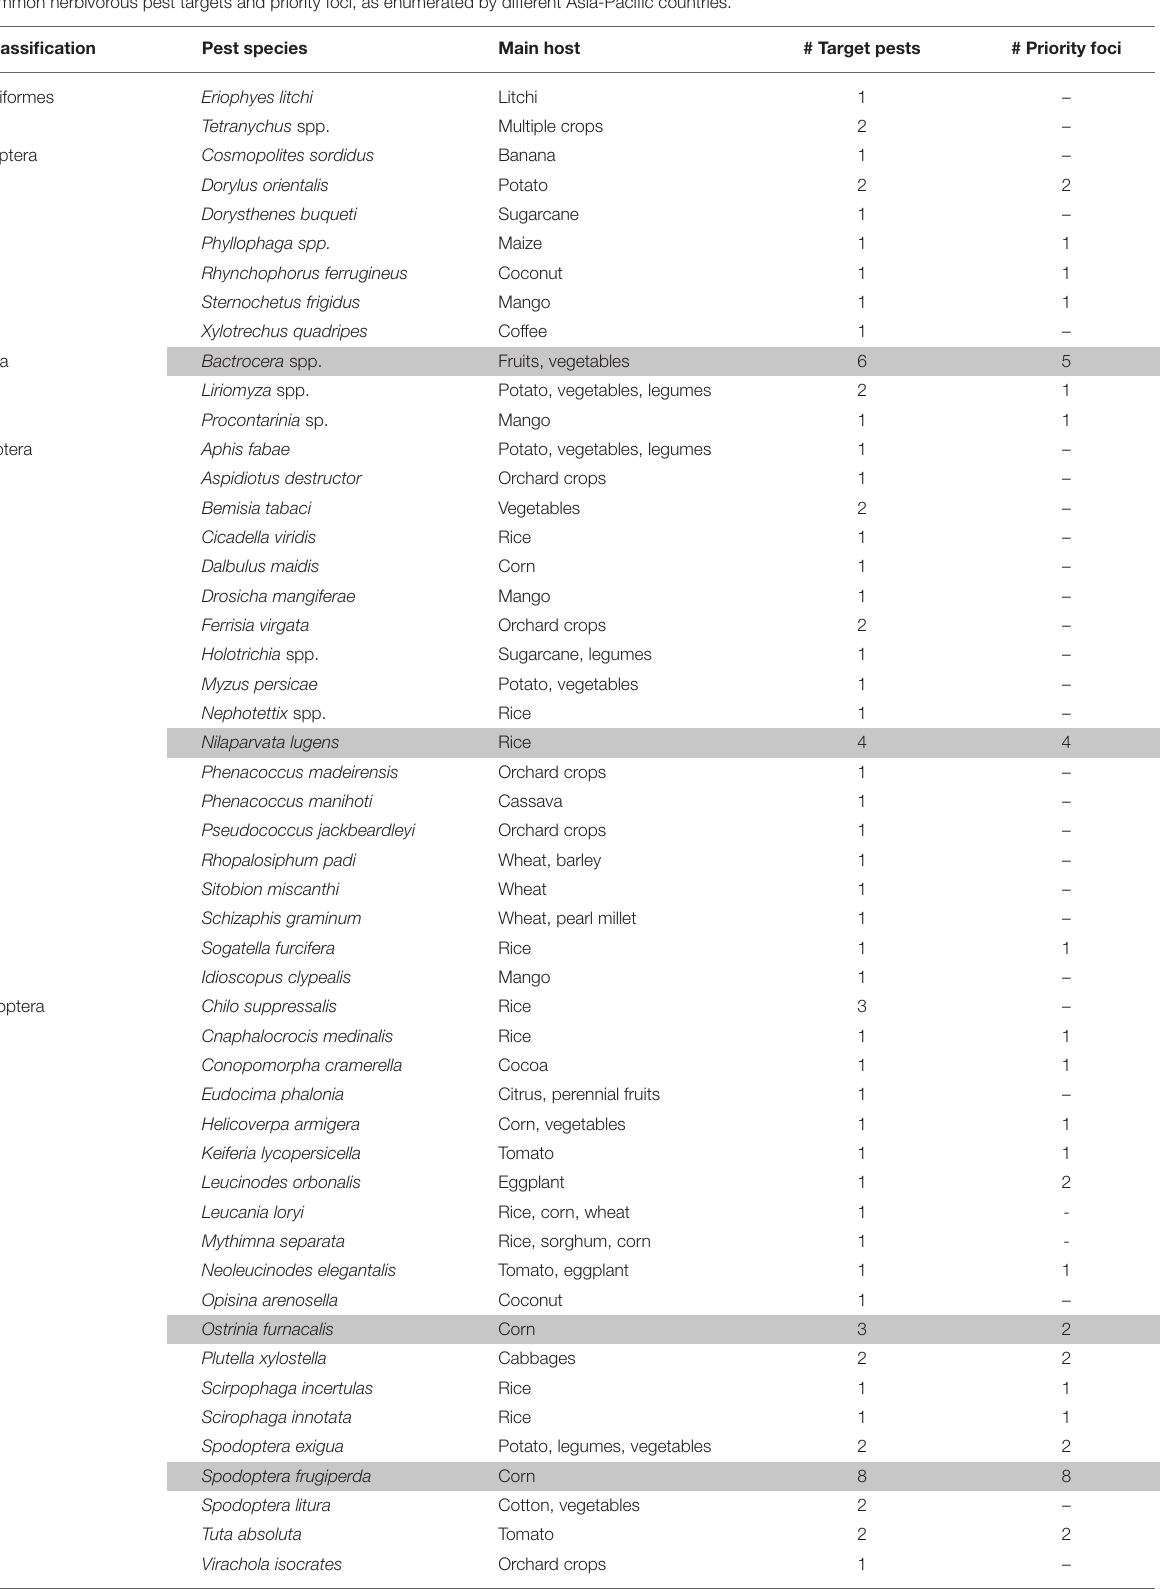
TABLE 2 | Common herbivorous pest targets and priority foci, as enumerated by different Asia-Pacific